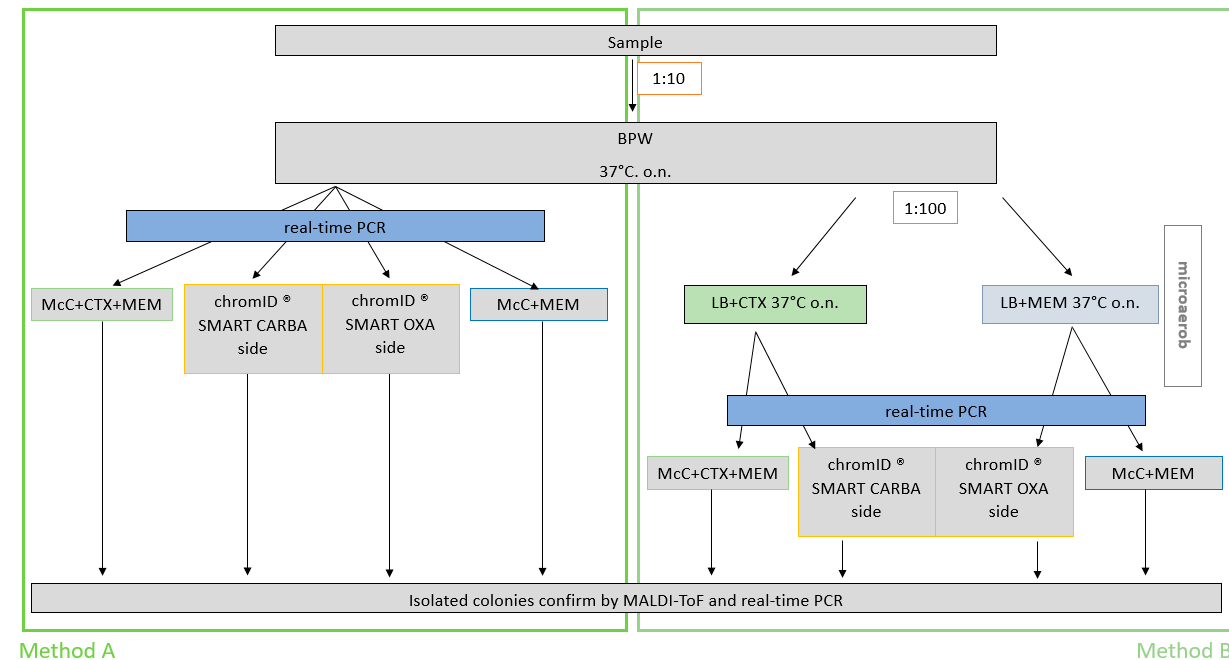
Figure 1. The whole procedure of method A and method B to compare both and to validate the agar plates. BPW = Buffered Peptone Water; McC+CTX+MEM = MacConkey Agar supplemented with 1mg/L cefotaxim and 0.125 mg/L meropenem; McC+MEM = MacConkey Agar supplemented with 0.125 mg/L meropenem; LB+CTX = lysogeny broth supplemented with 1mg/L cefotaxim; LB+MEM = lysogeny broth supplemented with 0.125 mg/L meropenem.